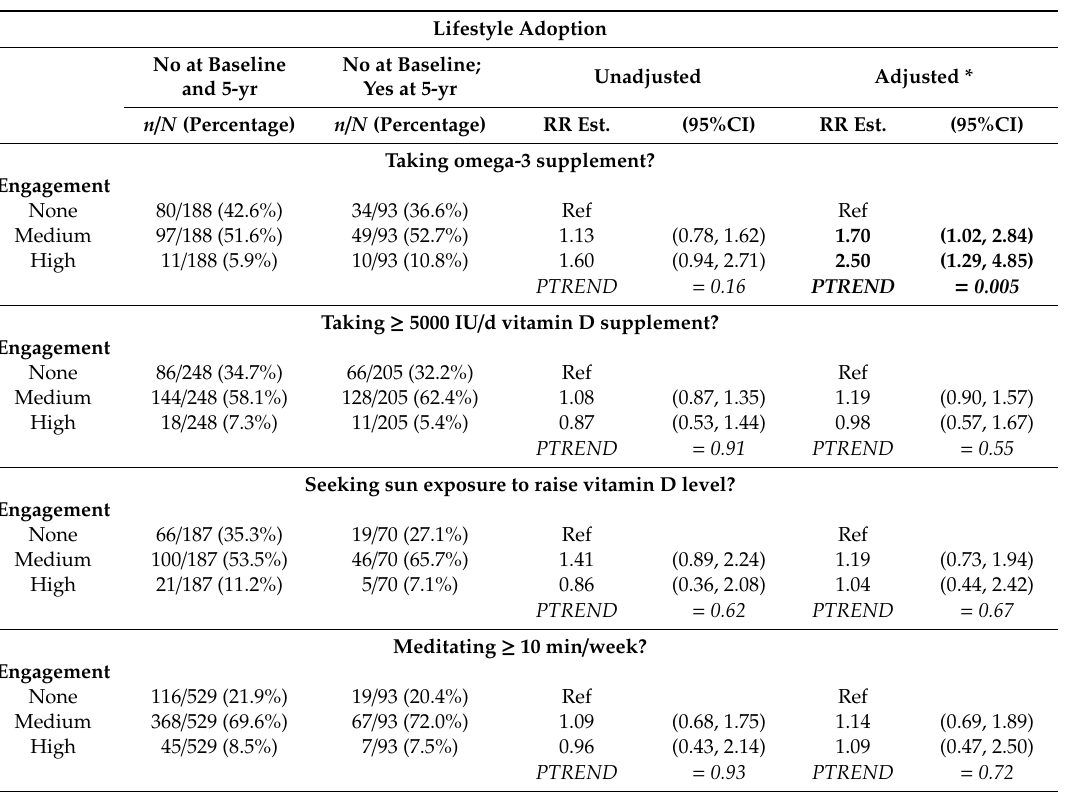
Table 4. Associations of adopting lifestyle behaviours at five years with baseline health communication